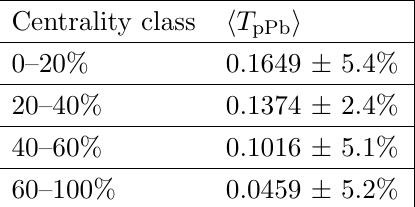
Table 1 . h T pPb i values in p-Pb collisions at using the ZNA, as described in